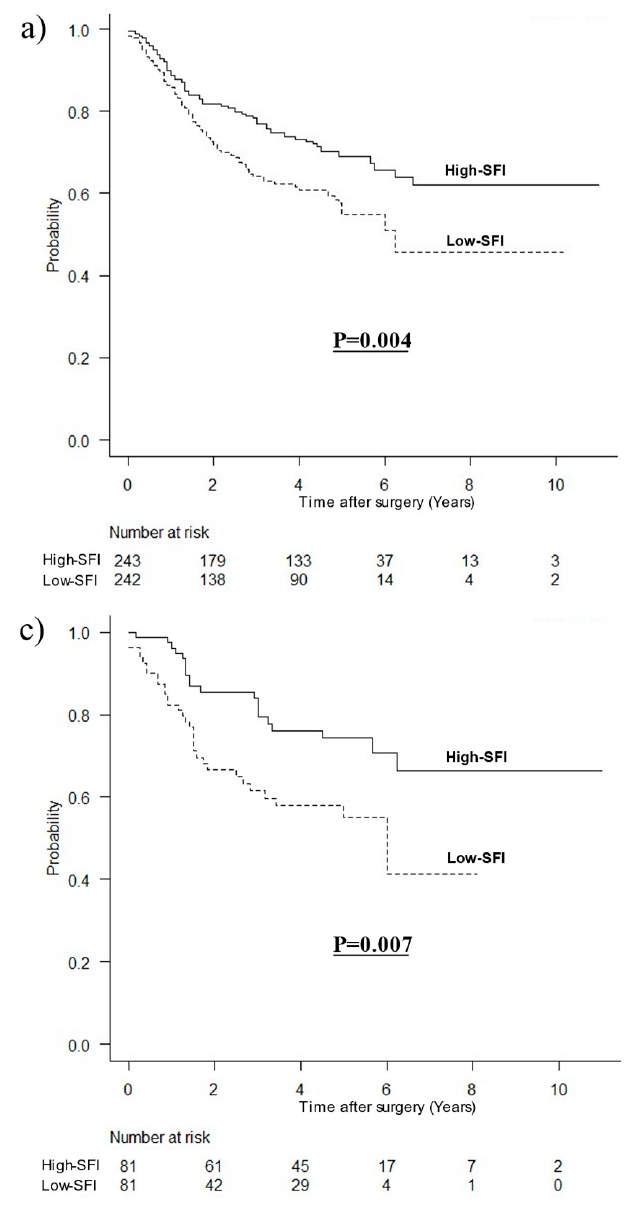
Figure 2. Kaplan–Meier survival curves for OS according to subcutaneous fat mass. ( a ) OS for all patients ( p = 0.004), ( b ) OS for men ( p = 0.105), ( c ) OS for women ( p = 0.007).